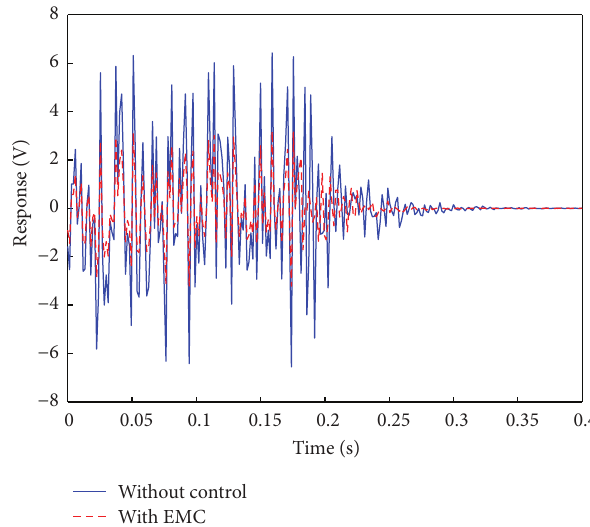
Figure 8: Vibration response at the quarter point of the first link.